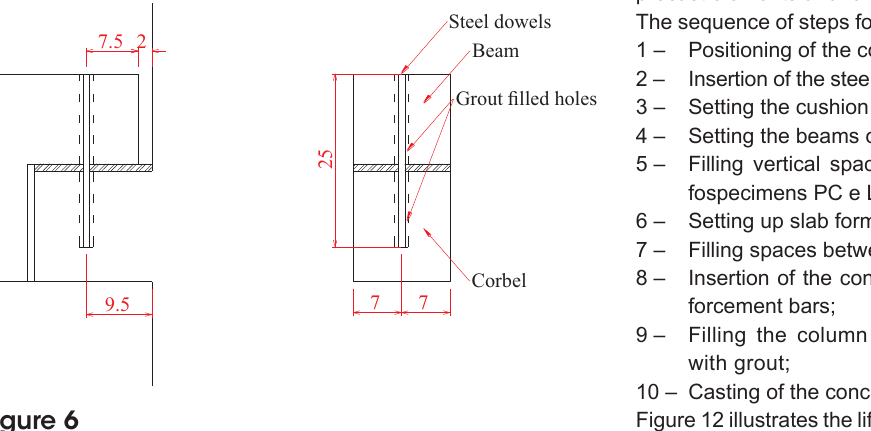
Position of the steel dowels (dimensions in cm)